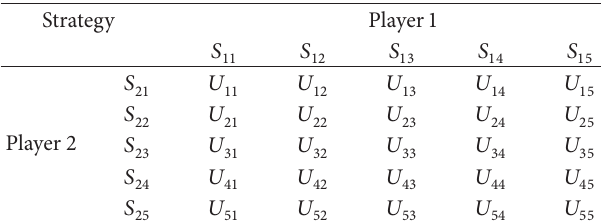
Table 7: The game